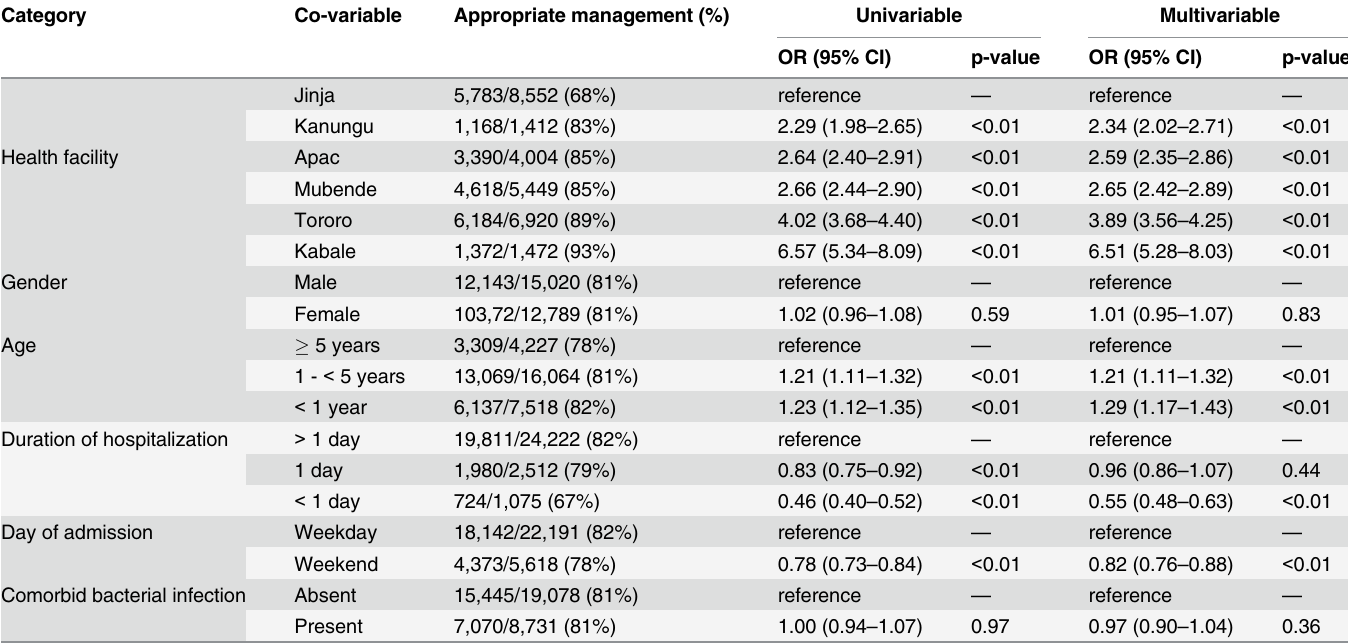
Table 4. Associations between characteristics and receipt of appropriate inpatient case management for suspected malaria.